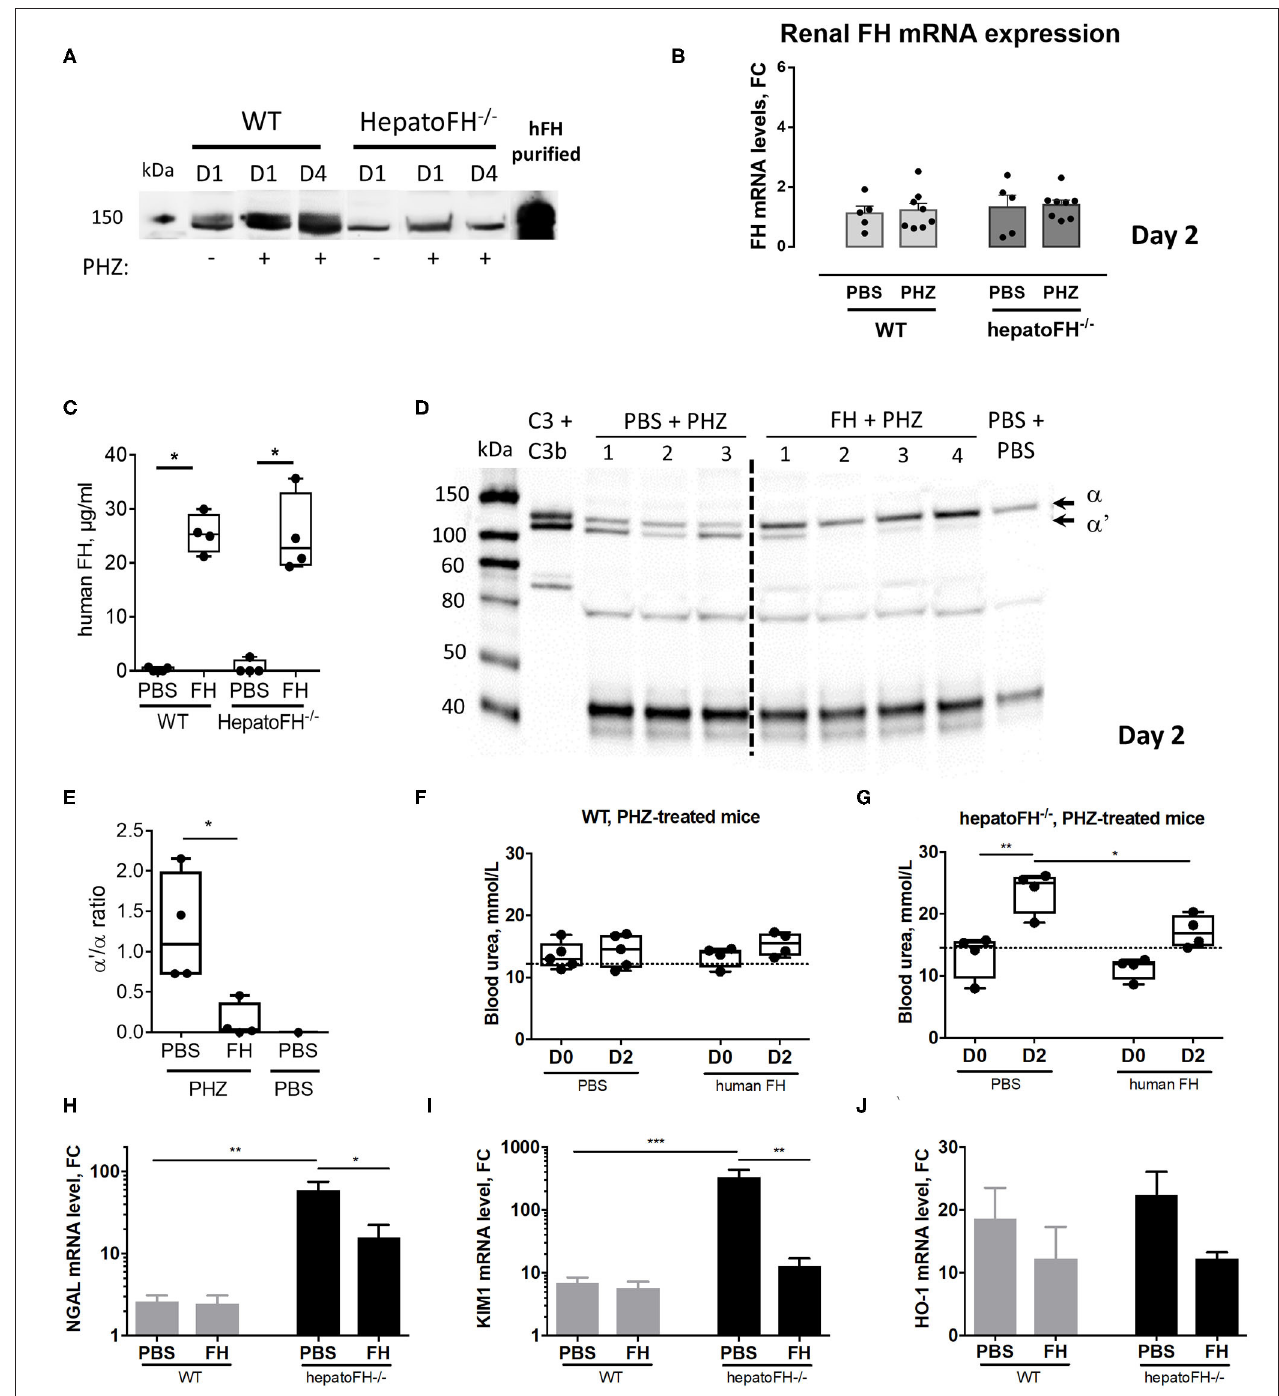
FIGURE 5 | Purified FH controls kidney injury in hemolytic conditions. (A) Measurement of plasma FH by WB after PBS or PHZ injection (Day 1 or 4 post-injection) in WT and hepatoFH − / − mice. Each lane correspond to 1 individual mouse. (B) Assessment of mRNA renal expression of FH in total kidney tissue. (C) Plasma human FH was assessed by ELISA at day 2 in WT and hepatoFH-/- mice, injected with human FH or PBS. (D) Plasma of hepatoFH − / − mice was resolved by electrophoresis and probed for C3 cleavage to C3b in hepatoFH − / − mice, treated or not with purified human FH. Each lane correspond to one individual mouse. (E) Quantification of the α ’/ α bands ratio, showing the absence of C3 activation in case of FH administration. (F,G) Blood urea was measured in plasma samples collected from PHZ-injected WT (F) or hepatoFH − / − (G) mice, pre-treated with human FH or PBS, at day 0 (D0) and day 2 (D2). (H–J) Assessment of mRNA renal expression for NGAL ( Lcn2 ) (H) , Kim-1 ( Havcr1 ) (I) and HO-1 ( Hmox1 ) (J) at day 2 in PHZ-treated WT and hepatoFH − / − mice pre-treated with human FH or PBS. P -values are